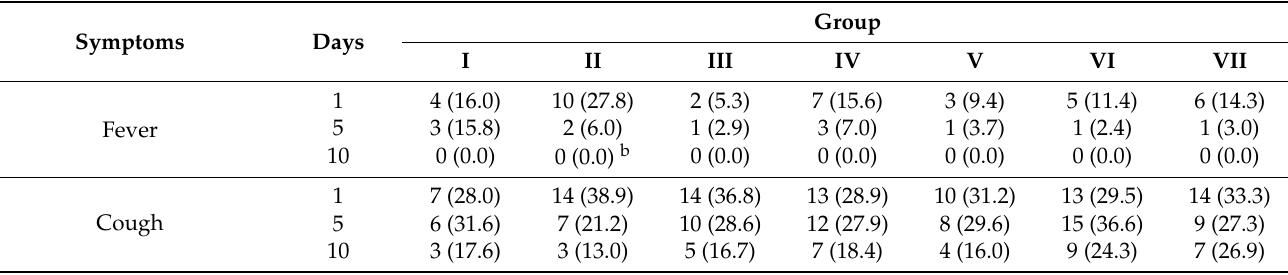
Table 2. Comparison of symptoms of